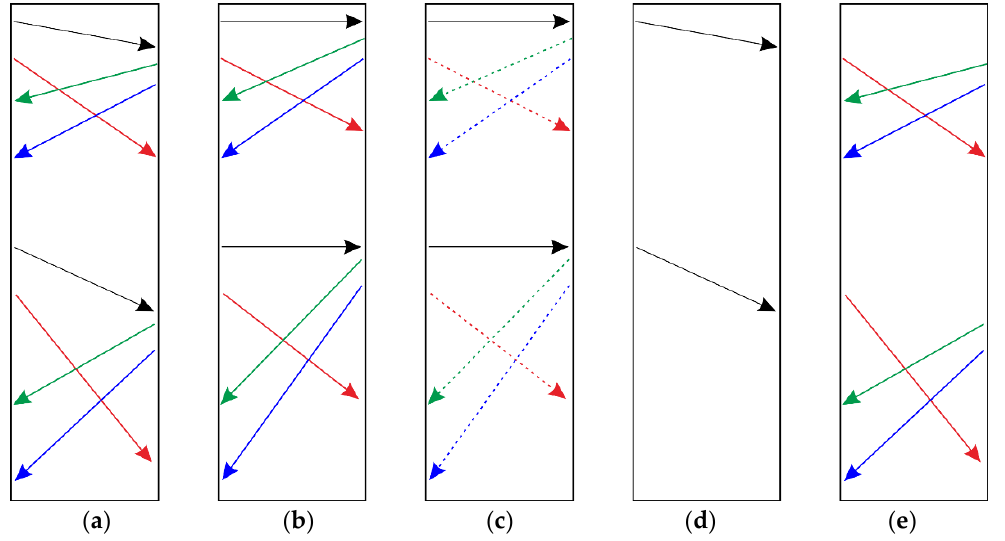
Figure 2. The process of separating a single wavefield using the new method. Black arrows denote downgoing P-wave events, red arrows denote downgoing S-wave events, green arrows denote upgoing S-wave events, and blue arrows denote upgoing S-wave events. ( a ) Original seismic data; ( b ) Dynamic aligned data; ( c ) Target wavefield after median filtering; ( d ) Target wavefield; ( e ) The remaining wavefield.